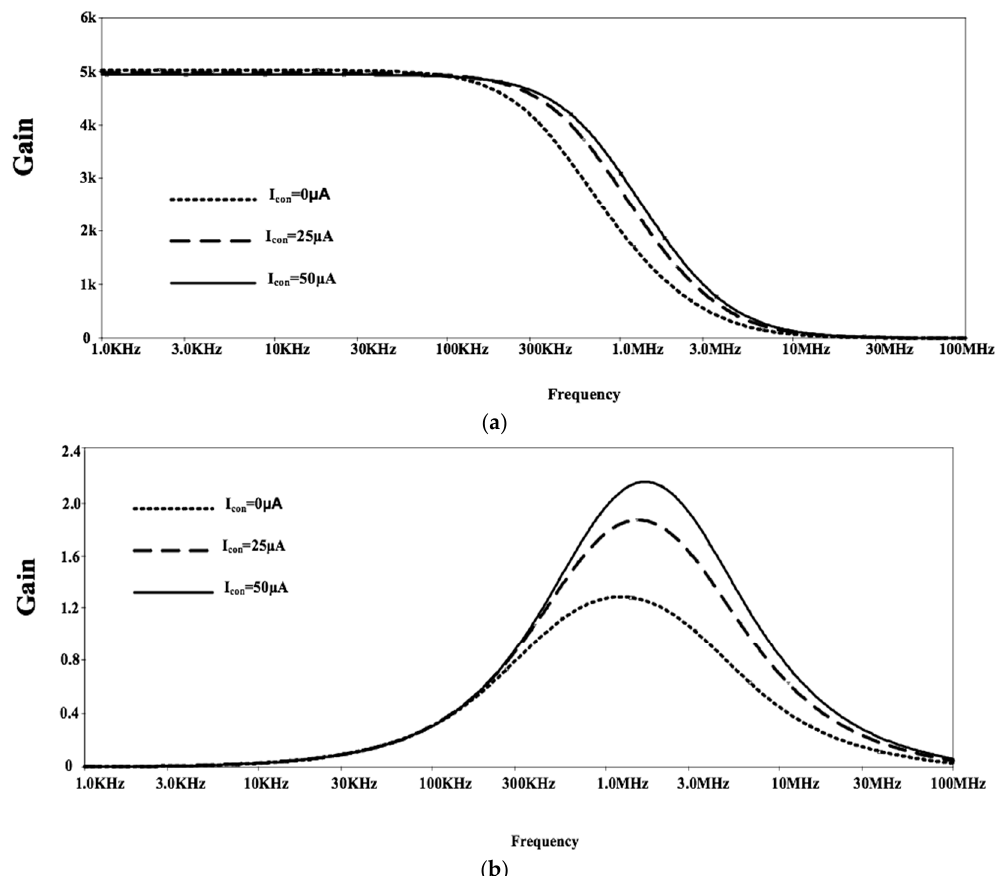
Figure 6. The values of the passive components were C 1 = 100 pF, C 2 = 10 pF and R 2 = 5 k Ω . Figure 8 shows the AC frequency performance of the LP and BP outputs for different values of I con . On the basis of the simulation results, ω 0 was 1.2 MHz, 1.59 MHz and 1.7 MHz for I con values of 0 μ A, 25 μ A and 50 μ A, respectively. On the basis of Equation (12), the values of ω 0 were 1.22 MHz, 1.54 MHz and 1.69 MHz, respectively. Fortunately, there is good agreement between the simulation and the calculation.